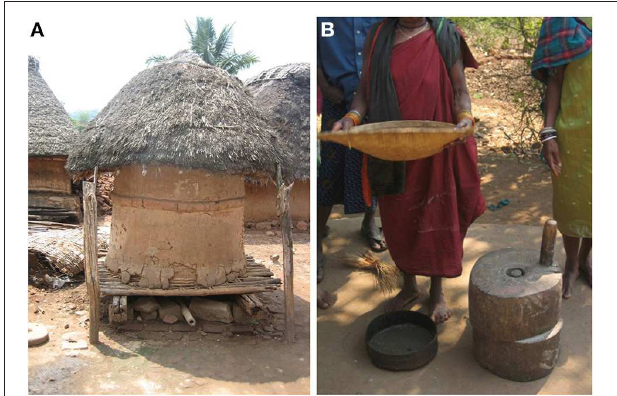
FIGURE 3 | Indigenous technologies and practices of modern small millet farmers. (A) A typical granary in the Eastern Ghats of India used for small millet storage. (B) A woman farmer in Northern India holds a basket used for separating millet grain from chaff. She stands beside a manual millstone used for grinding millet grain into flour. Source: M.